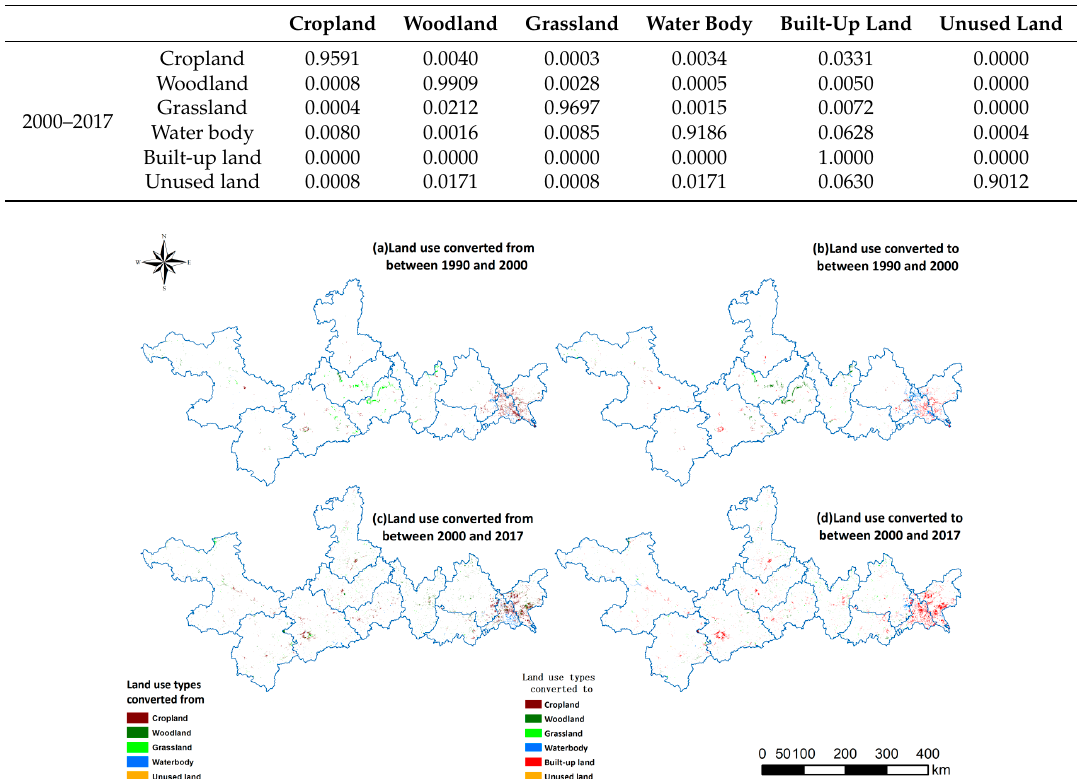
Table 5. Land-use transition possibilities, 2000–2017.